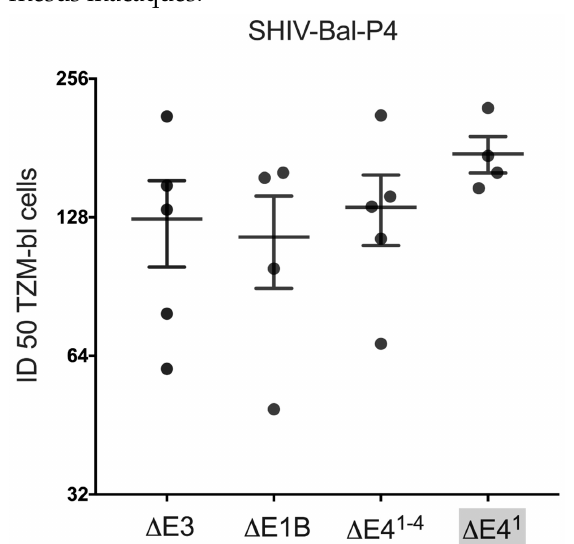
Figure 7. Neutralizing antibody titers in Ad vector immunized rhesus macaques. The neutralization levels of antibodies against SHIV Bal-P4 for the different vectors were assessed at wk 38, as described in Materials and Methods.